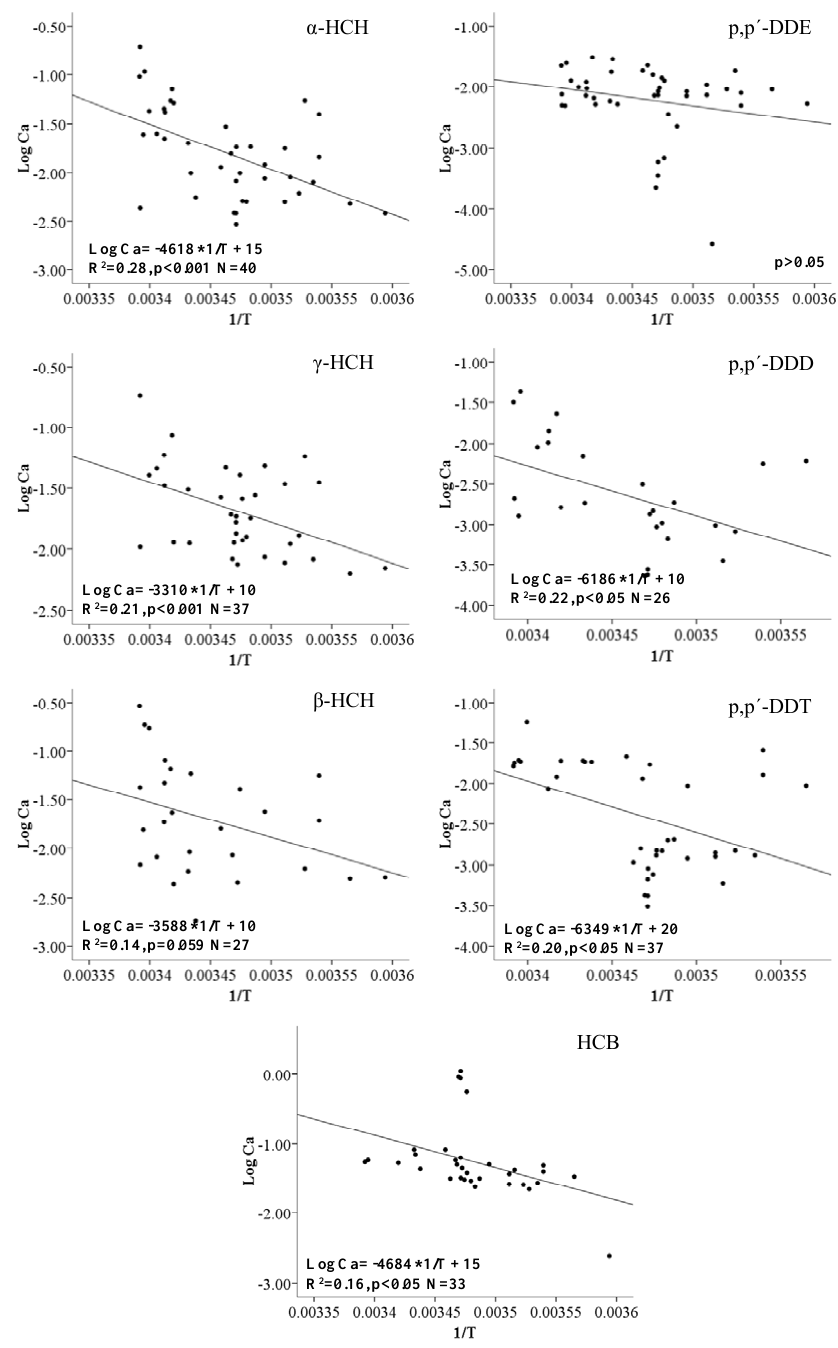
Fig. 1. Ambient air concentration (Log Ca in ngm − 3 ) regressed against 1/ T for selected HCH isomers, DDT metabolites and HCB.